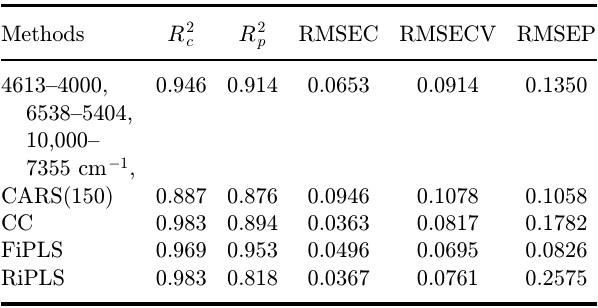
Fig. 6. The results of RMSEP values with di®erent low absorbance thresholds. Table 3. The PLSR models results of di®erent variable selection methods.